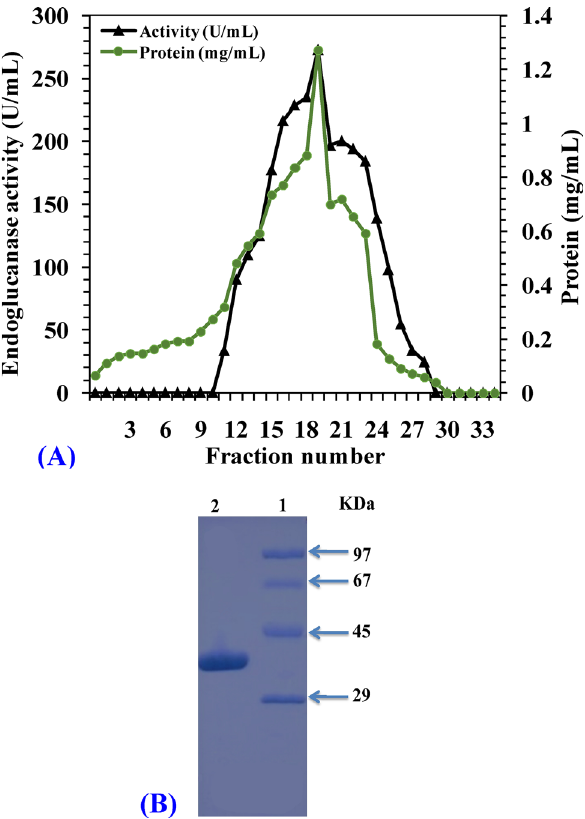
Figure 8. ( A ) Fractionation of endoglucanase enzyme by DEAE-Sepharose CL6B column ( B ) Molecular weight determinations by SDS-PAGE method. On the right side, marker proteins: Phosphorylase B (97 kDa), Bovine serum albumin (67 kDa), Ovalbumin (45 kDa) and Carbonic anhydrase (29 kDa). On the left side, purified